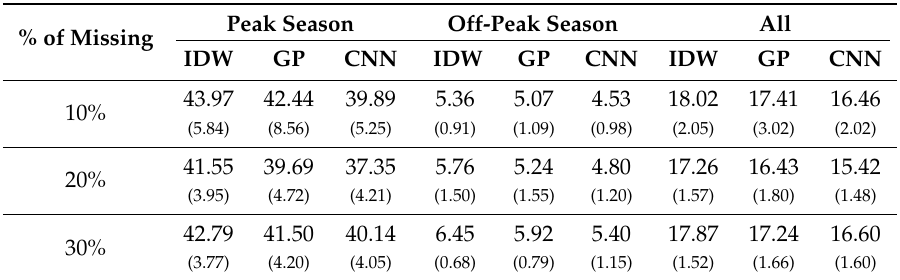
Table 1. Average and standard deviation (in parenthesis) of the RMSE per percentage of missing data and